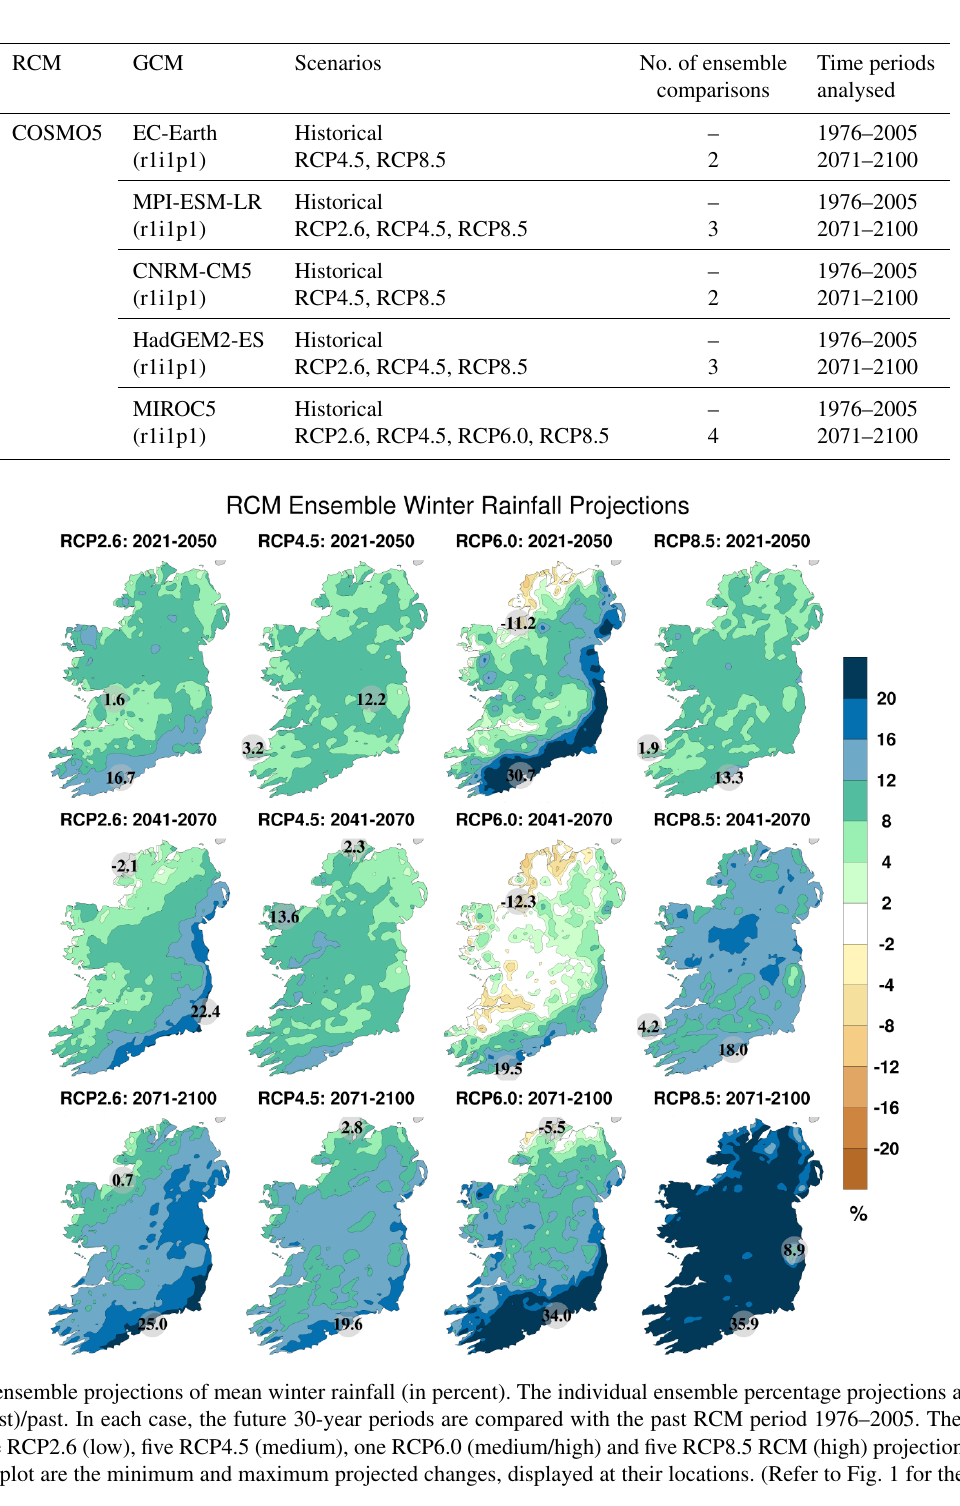
Table 1. Details of the ensemble RCM simulations used in this study. Rows present information on the RCM used, the corresponding downscaled GCM, the RCP used for future simulations, the number of ensemble comparisons and the time slice analysed. In each case, the future 30-year period, 2071–2100, is compared with the past RCM period 1976–2005. The mean of three RCP2.6, five RCP4.5 and five RCP8.5 RCM projections were calculated. The RCP6.0 simulation comprises just one simulation, so it was compared directly with the past RCM period.